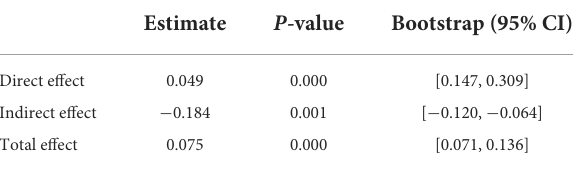
TABLE 4 Mediating effect of